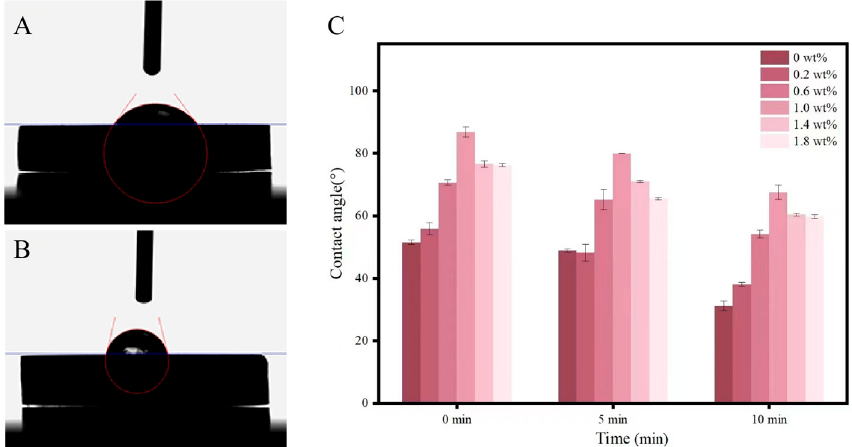
Figure 5. ( A ) Water contact angles of hAP (0 wt%) surfaces; ( B ) Water contact angles of hAP (1 wt%) surfaces; ( C ) Contact angle measurement results of hAP (0, 0.2, 0.6, 1.0, 1.4, 1.8 wt%)